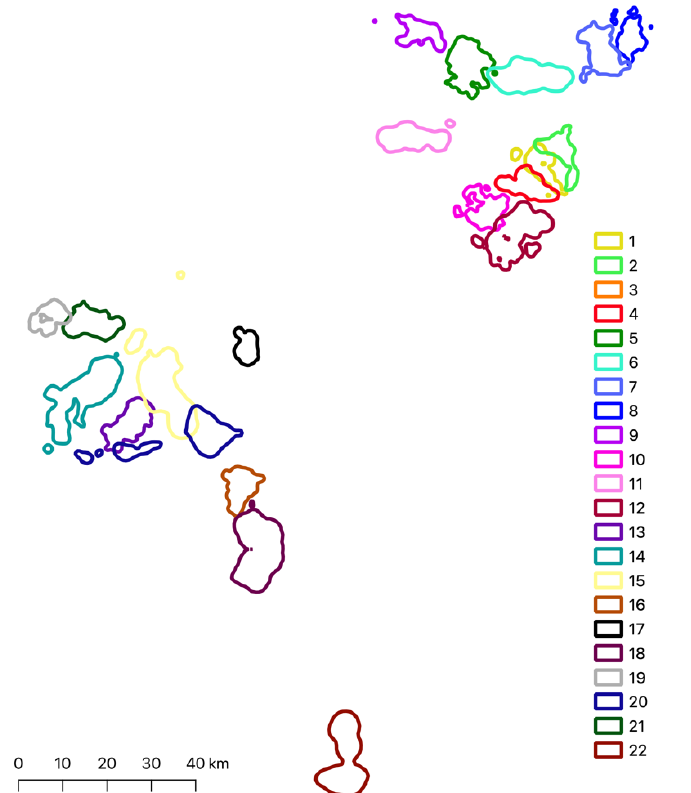
Figure 1. Spatial arrangement of 22 Bonelli’s eagle territories in the study area. Due to conservation reasons, the map is hidden to avoid the exact location of each territory.